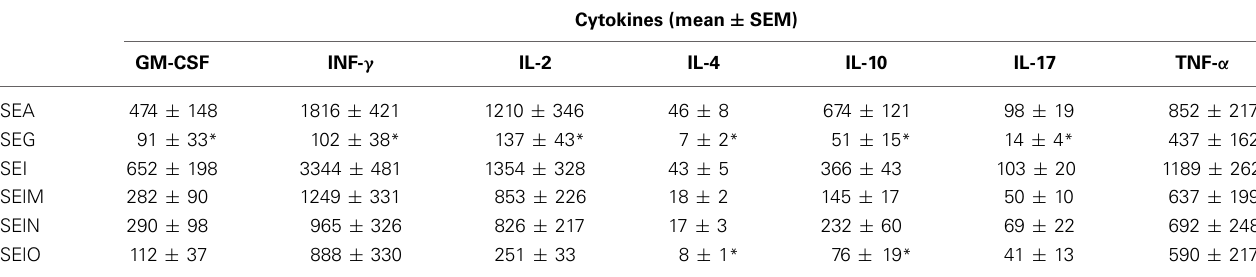
Table 1 | Level of cytokines in supernatants of PBMC stimulated by SEA, SEG, SEI, SElM, SElN, and